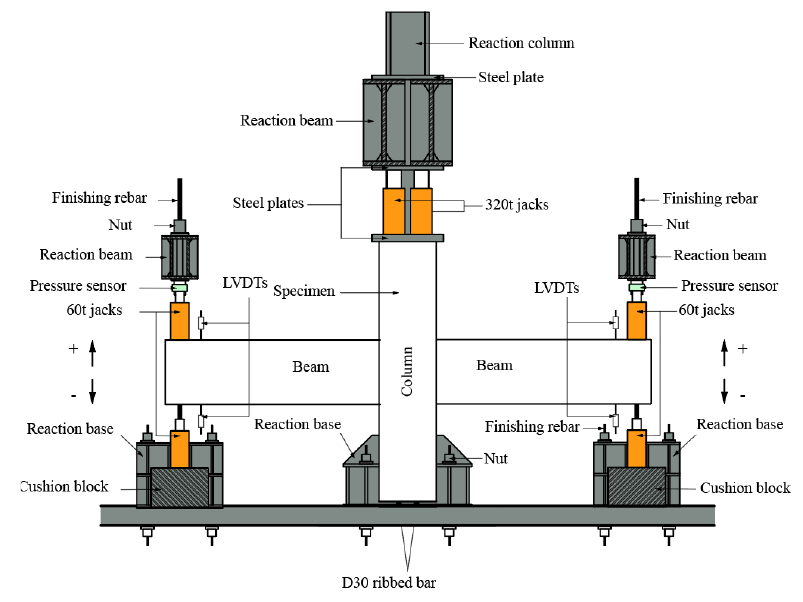
Figure 2. Schematic configuration of the test setup.